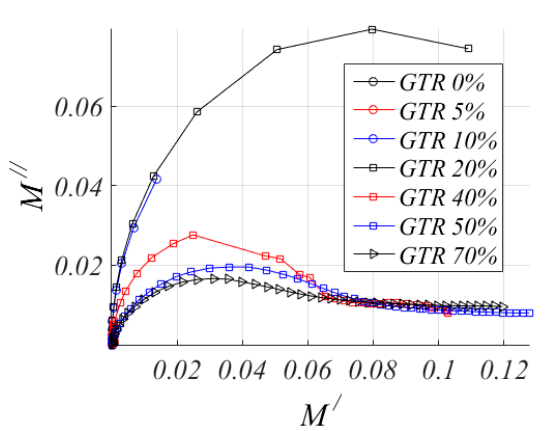
Figure 11. Argand Diagram (M’’-M’) for LLDPE/GTR blends at a temperature of 120 °C .